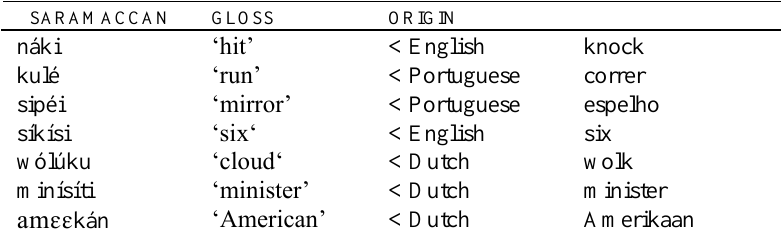
Table I: Some Saramaccan words of European origin